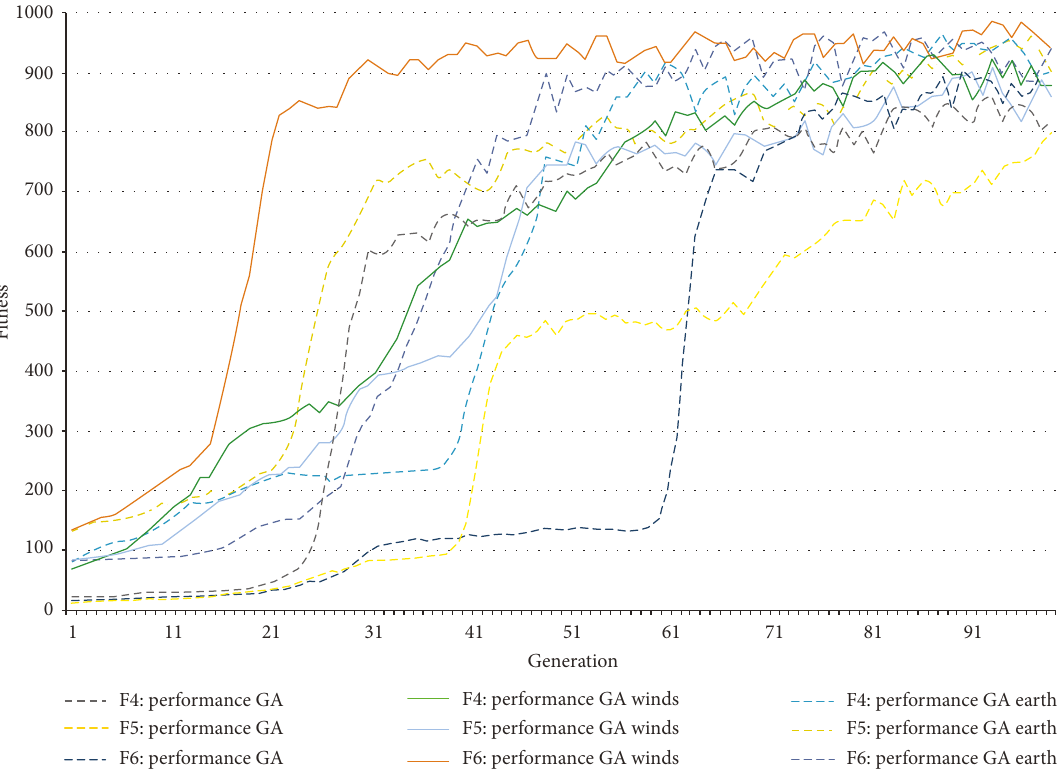
Figure 4: Evolution of the results in each generation with test functions F4, F5, and F6 using GA, GAP winds, and GAP